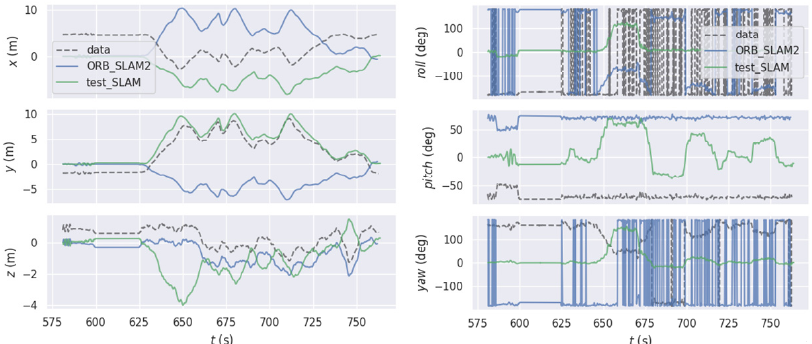
Figure 6. The comparison in APE of two algorithms in the KITTI dataset.